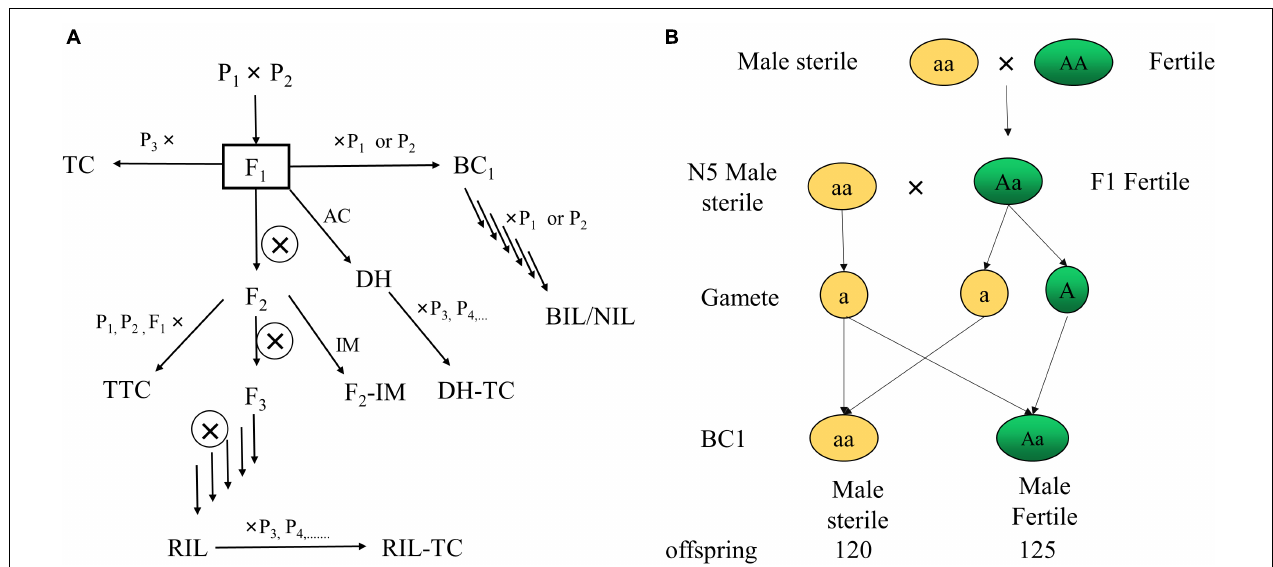
FIGURE 4 | Classification of mapping populations (A) (Xu, 2010) and strategy of population construction through sterile male QTL mapping (B) . P n , parent; F1, filial generation 1; AC, mapping population can be classified into anther culture; BC, backcross population; BIL, backcross inbred line; DH, double haploid; IM, intermating; NIL, near-isogenic line; RIL, recombinant inbred line; TC, testcross; TTC, triple testcross; N5, a sterile male cultivar of L. barbarum